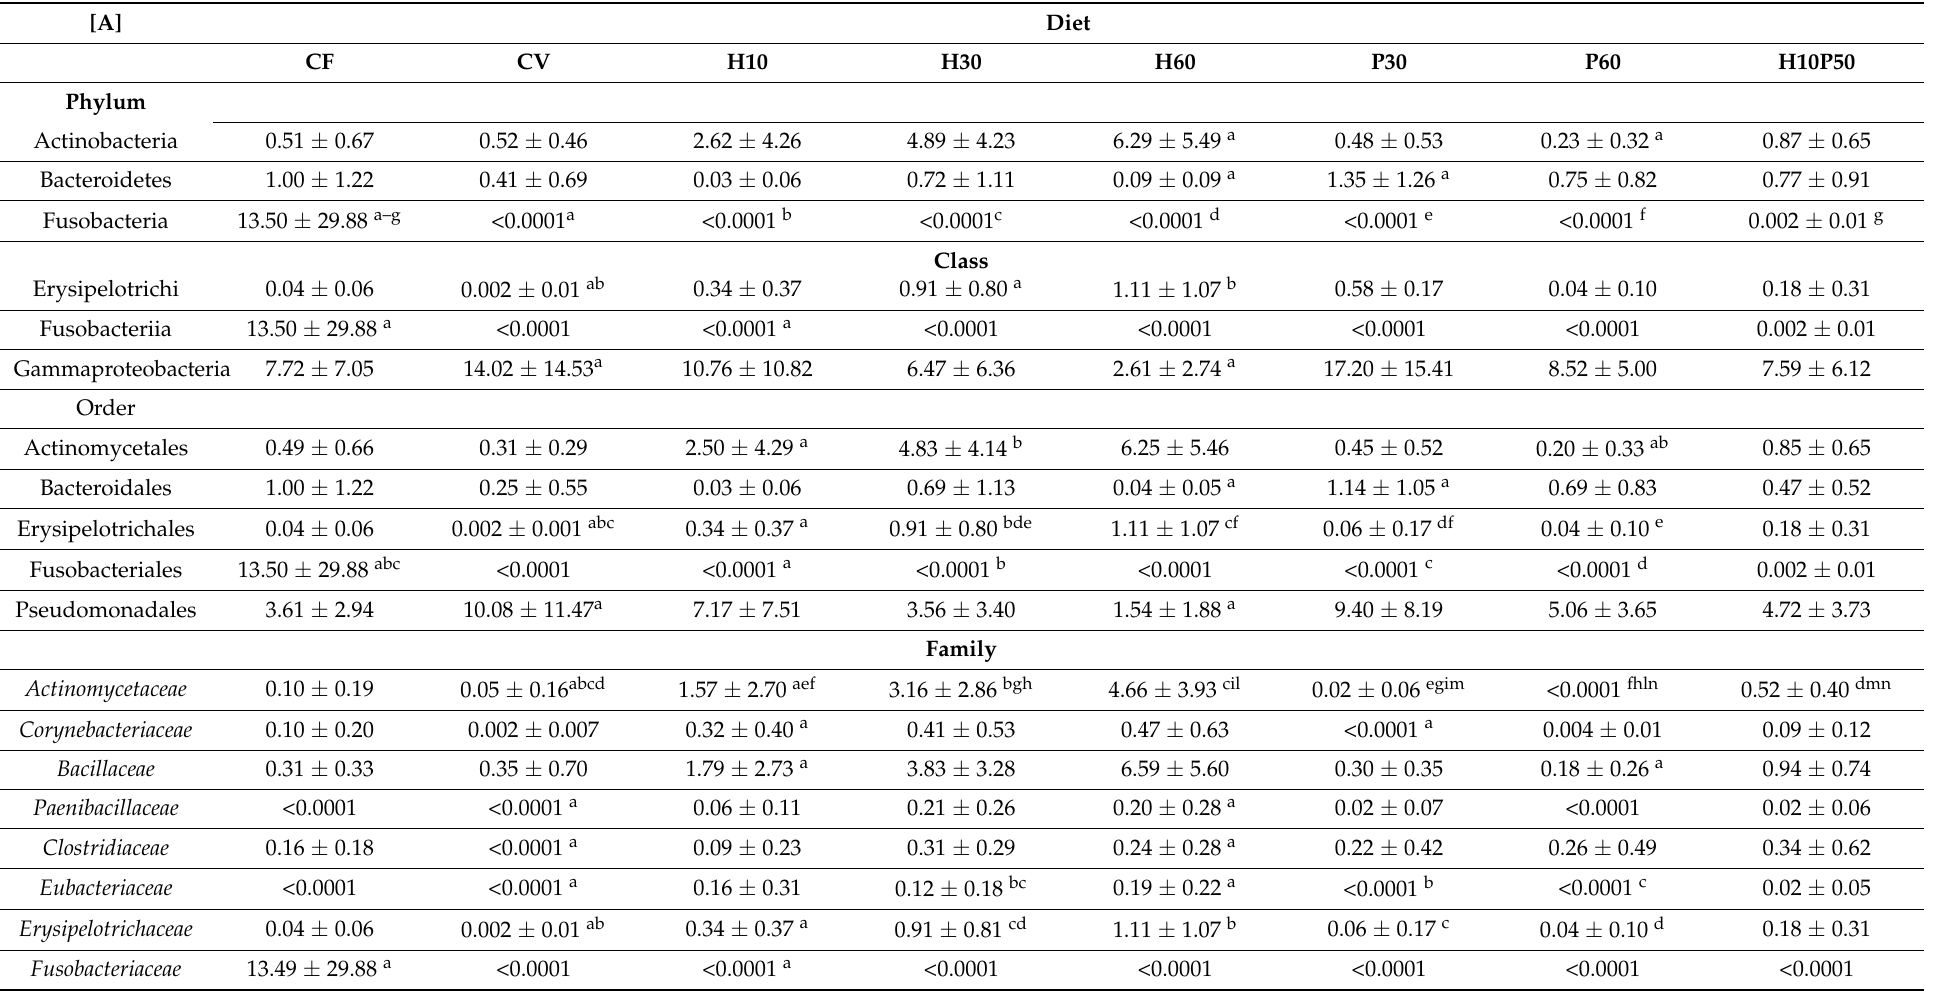
Table 2. ( A – B ) Bacterial relative abundances (mean ± SD) of taxonomic groups that were significantly different between diet groups. Identical superscript letters indicate significant differences among treatments according to Benjamini-Hochberg FDR correction. Individual p values are reported in the text and in Table